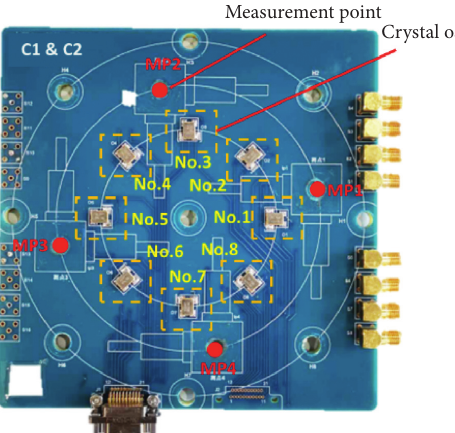
Figure 5: Recoverable frequency jumping of the oscillator.